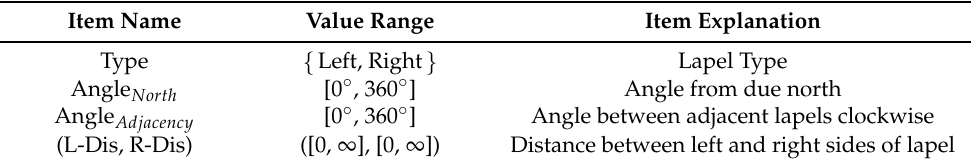
Figure 13. (L-distance, R-distance) of lapel point: ( left ) DEM skyline with the position of a lapel point denoted by a red dot; and ( right ) the depth of the skyline in ( left ), where the red line denotes the difference in depth in ( left ), and the L-distance and R-distance are denoted by black arrows, representing the depth of left and right sides of lapel point, respectively. Table 1. DEM lapel points information list.